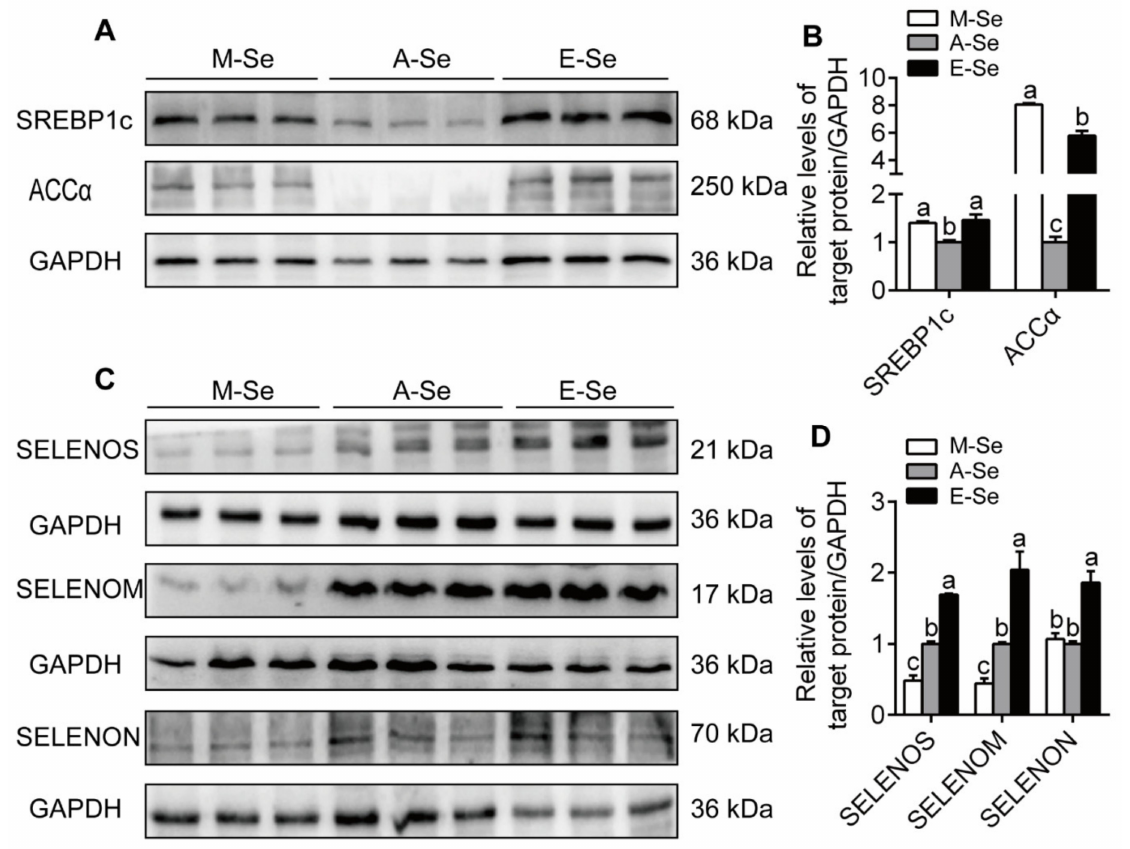
Figure 7. Relative protein expression of intestine SREBP1c and ACC α ( A , B ) and SELENOF, SELENON, and SELENOS ( C , D ) in yellow catfish fed diets varying in Se level for 12 wk. GAPDH was used as internal standard. Values are means ± SEMs, n = 3 (replicates of 3 fish). Labeled means without a common letter differ, p < 0.05 (one-factor ANOVA, Duncan post hoc